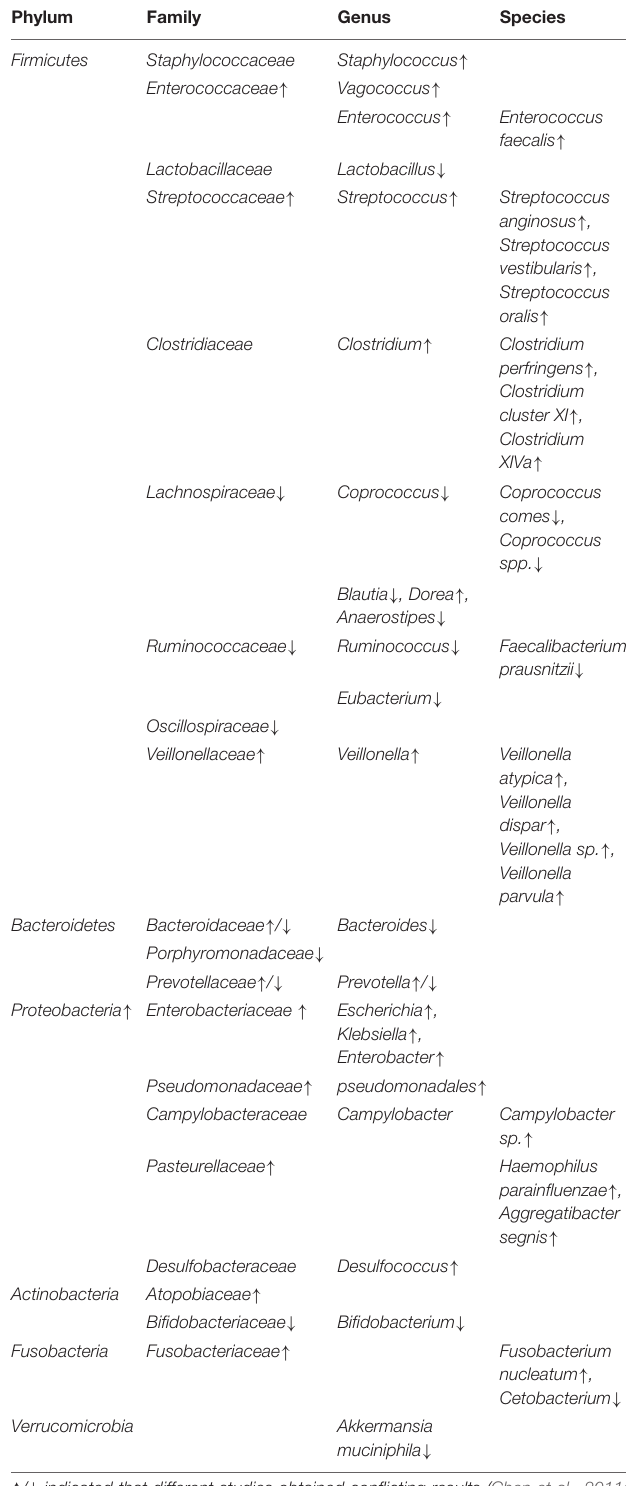
TABLE 1 | Current findings of gut microbial characteristics for cirrhosis- hepatocellular carcinoma patients.